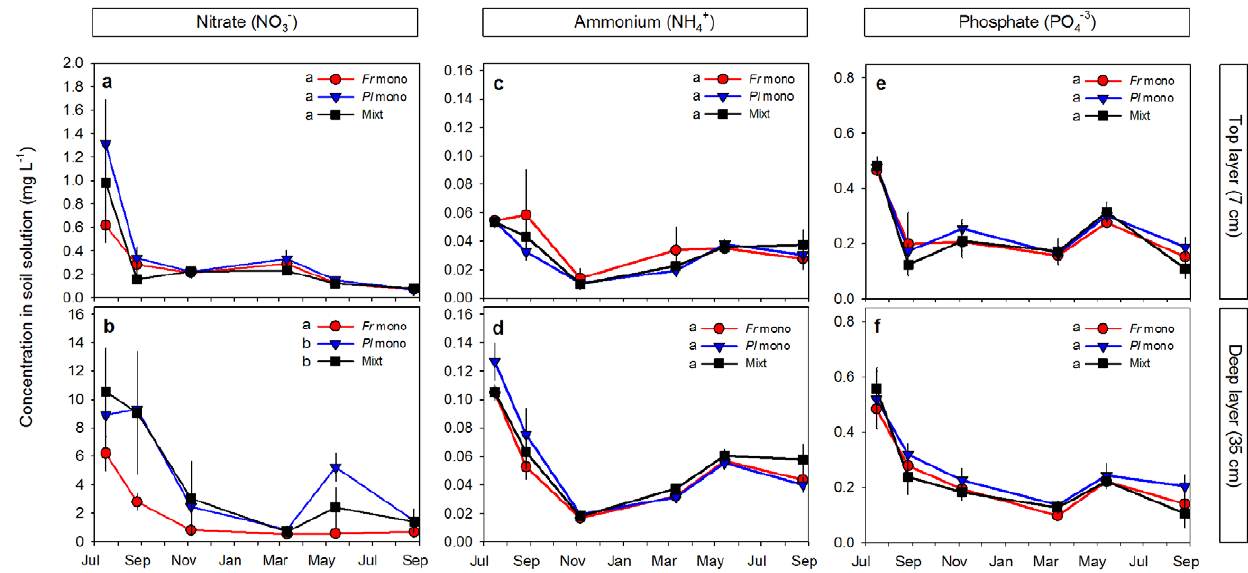
Figure 3. Nutrients dynamics in soil solution over time. Nitrate ( a, b ), ammonium ( c, d ) and phosphate ( e, f ) concentration in Festuca rubra and Plantago lanceolata monocultures and in mixtures of the two species, at 7 and 35 cm depth. In nitrate, different letters in legends show significant differences between species over time, after ANCOVA layer x species . Data are means 6 SE, N=3–4. No significant second and third order interactions involving species and time were detected (Table 1), meaning that similarities/differences between species were consistent all over the experimental period. Soil nutrient concentrations were derived from regular sampling of soil water over the course of the experiment through porous suction cups that had been placed in the soil